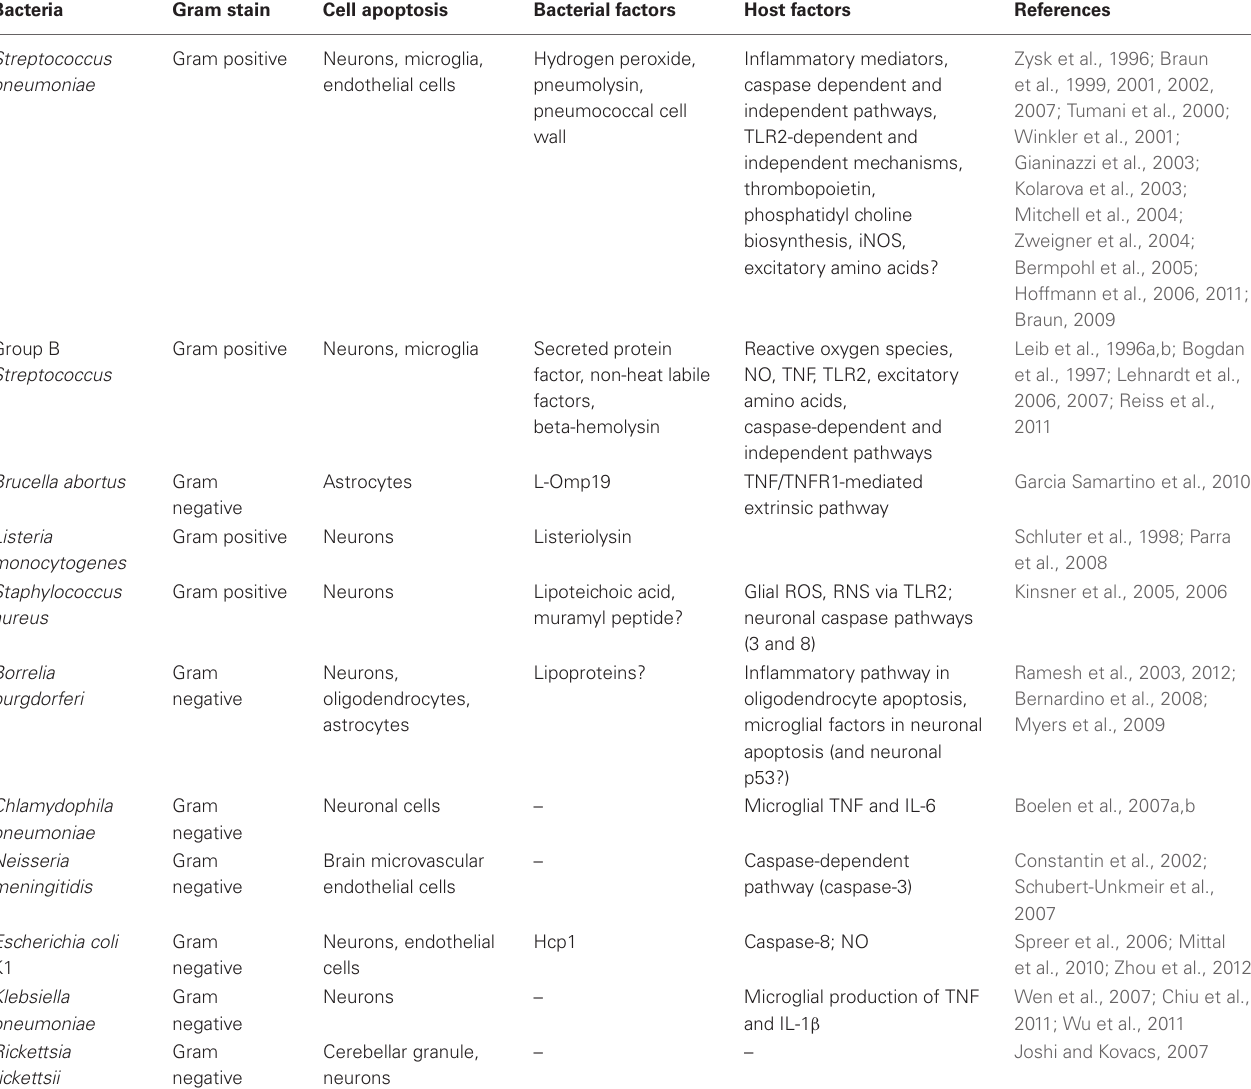
Table 1 | CNS apoptotic mechanisms in bacterial infections.